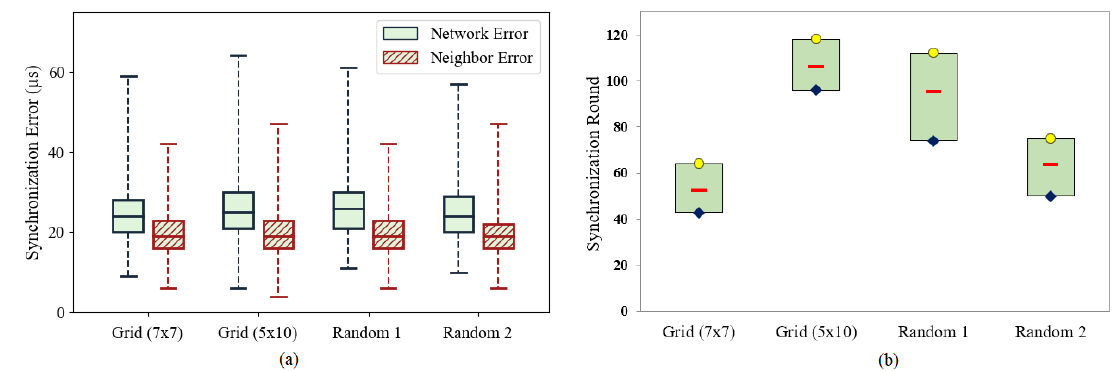
Figure 11. ( a ) Network error and maximum neighbor error of GTSP with different topologies.